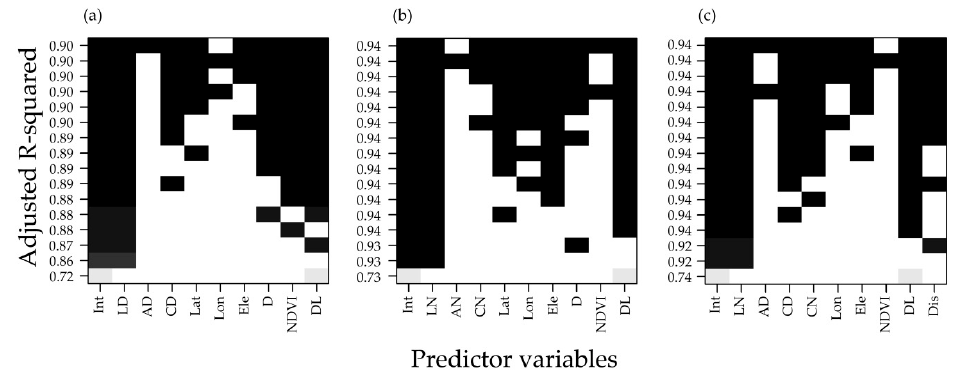
Figure 2. Best models for each subset size based on Adjusted R-squared, ( a ) T max , ( b ) T min , and ( c ) T mean variable selection. LD: 8-Day daytime 1 km grid land surface temperature, AD: Average view zenith angle of daytime land surface temperature, CD: the days in clear sky conditions and with valid daytime land surface temperature observation, LN: 8-Day nighttime 1 km grid land surface temperature, AN: Average view zenith angle of nighttime land surface temperature, CN: the days in clear sky conditions and with valid nighttime land surface temperature observation, Lat: Latitude, Lon: Longitude, Ele: Elevation, Dis: The distance to the coastal line, D: Julian day, DL: Mean day length of 8-Day day length, NDVI: Normal difference vegetation index.